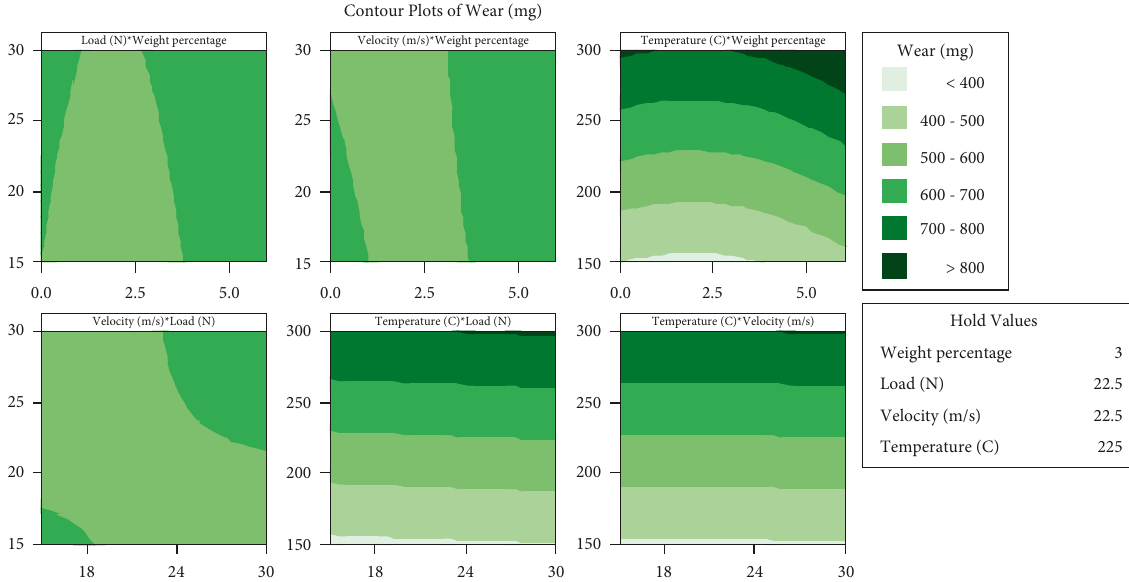
Figure 4: Interaction impact of various process parameters on wear of AA7050/Al2O3 composites.